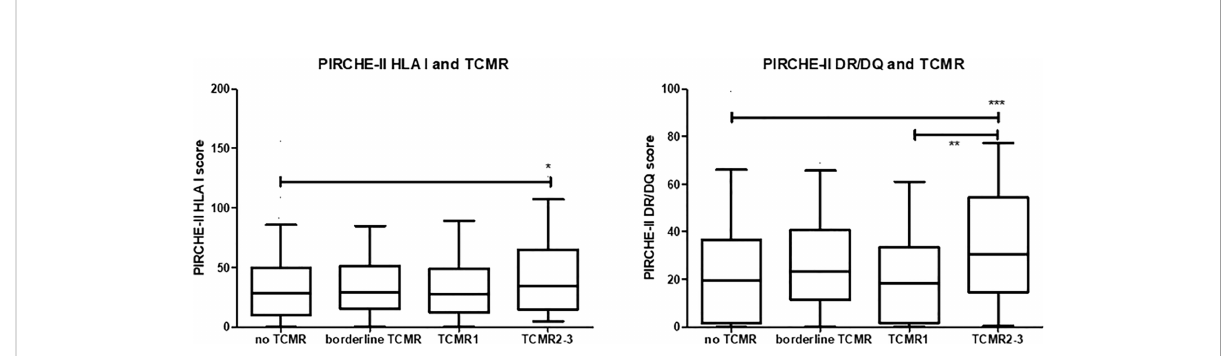
FIGURE 1 The PIRCHE-II score for donor HLA I and HLA II (DR/DQ) given in box-whisker plots for the different groups of recipients; no T cell-mediated rejection (TCMR), borderline TCMR, tubule-interstitial TCMR grade 1 and vascular TCMR grade 2-3. The p-value for the Kruskal-Waliss test for difference between multiple groups was <0.001. Post-hoc analysis for comparison between groups: *p<0.05, **p< 0.01,